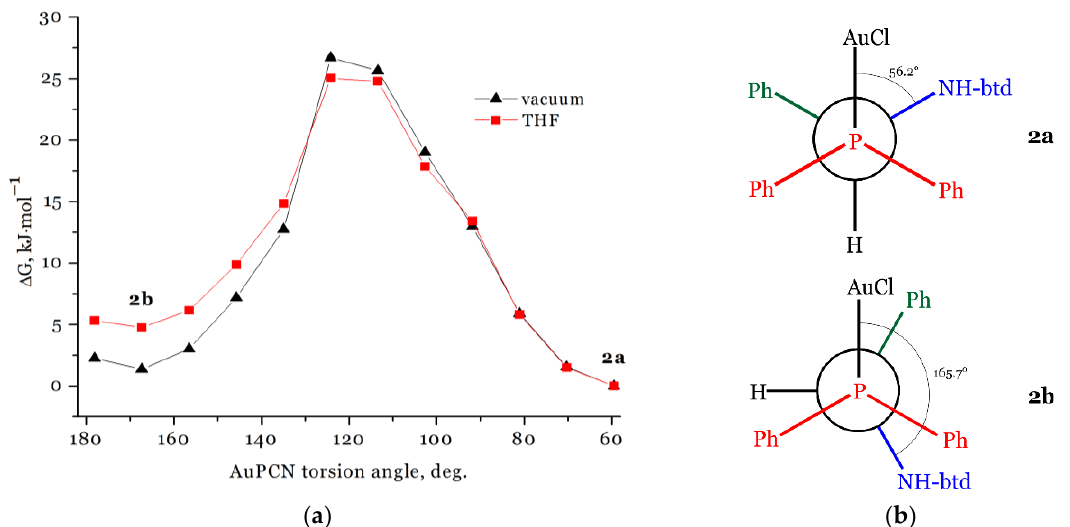
Figure 2. ( a ) Gibbs energy scans of {AuPPh 2 Cl} moiety rotation around the P – C bond for the mole- cule [Au( PCN )Cl]. ( b ) Schematic representation of the corresponding conformers 2a and 2b .